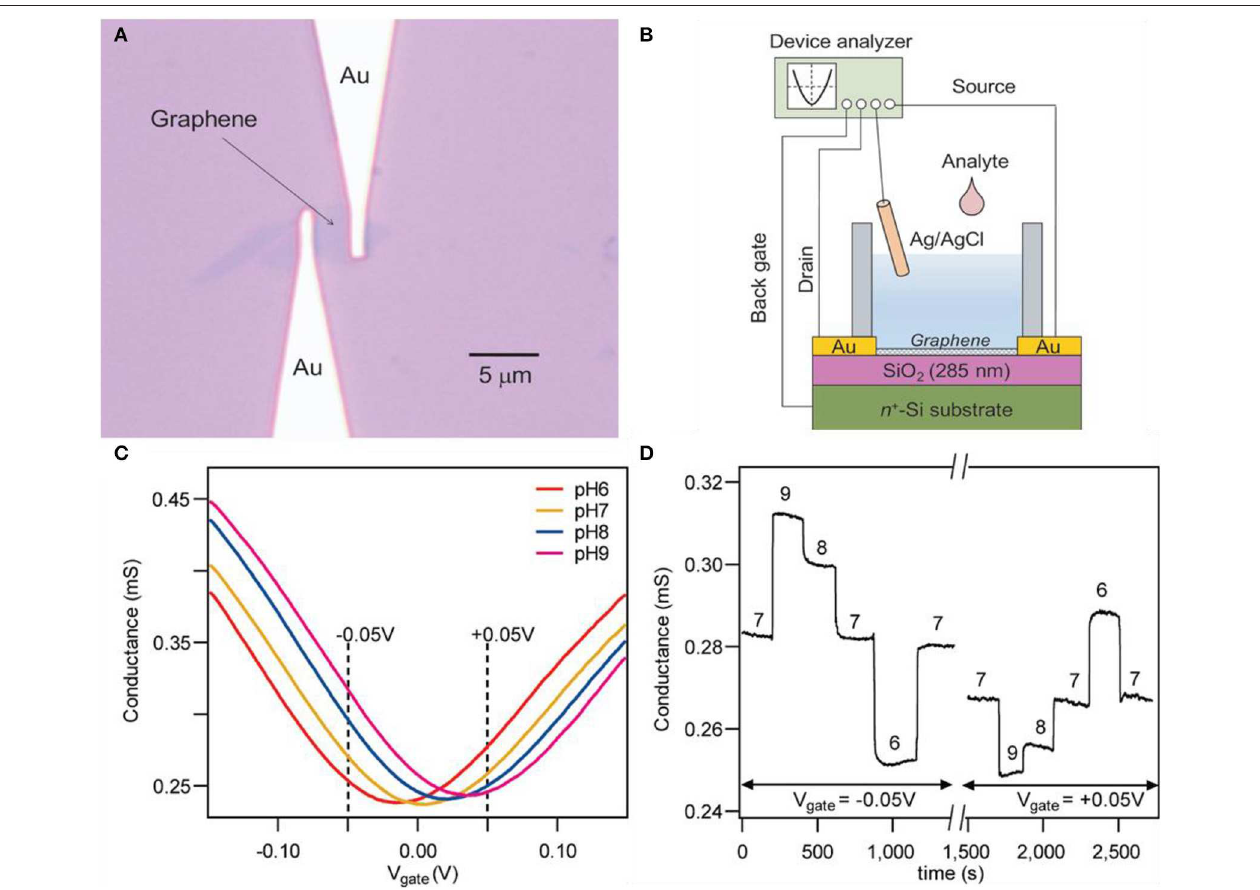
FIGURE 2 | Pristine graphene pH sensors. (A) Optical microscope image of a graphene field effect transistor. (B) Experimental setup scheme illustration of a graphene field effect transistor. Figures (A,B) were reproduced from Ohno et al. (2009) with permission from the American Chemical Society. (C) Typical transfer curves and